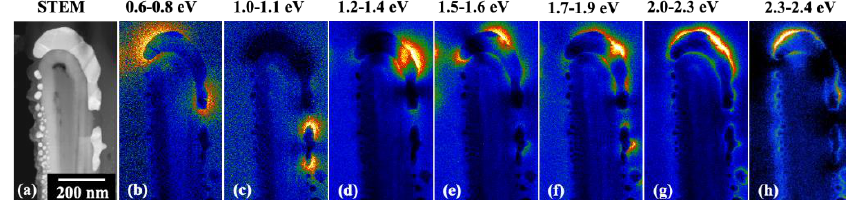
Figure 13. ( a ) STEM image shows the inverted FH structure and the presence of other Au nanoparticles. ( b – h ) Plasmonic modes observed at different energy widows. Each EF map is represented in temperature mode, the color scales are independent of each other, and higher electron energy loss events are shown in yellow, while the dark blue regions indicate lower energy loss events. Adapted from [86] with permission from the PCCP Owner Societies, 2017.